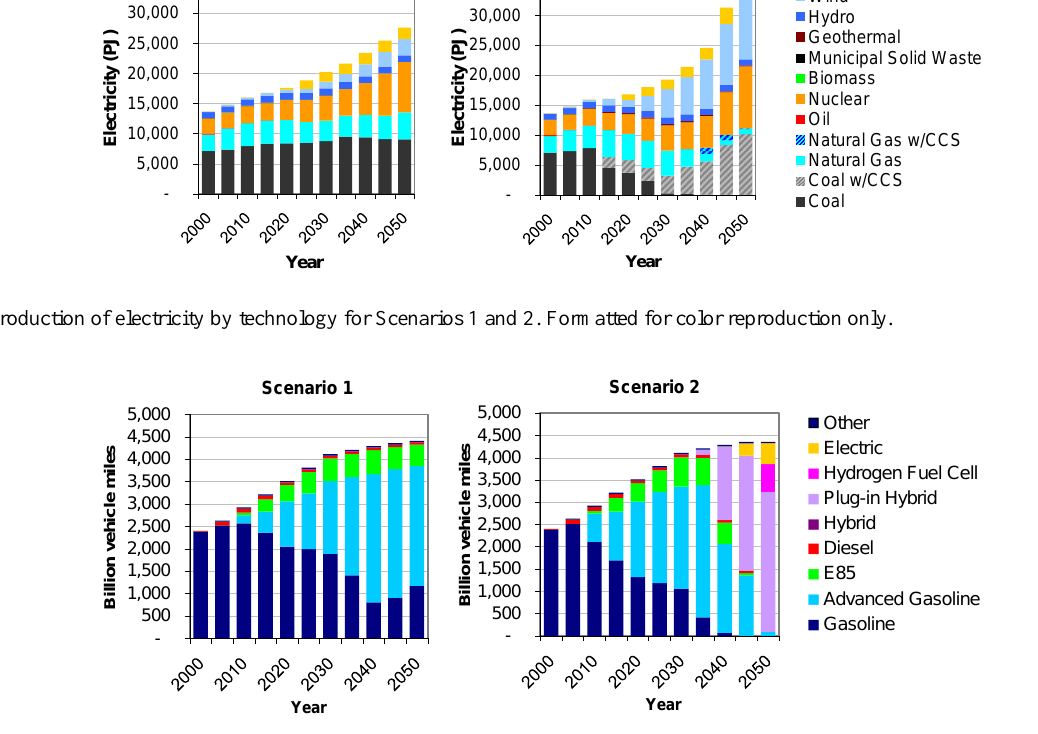
Fig. 4. Market share of light duty vehicle technologies for Scenarios 1 and 2. Formatted for color reproduction only.